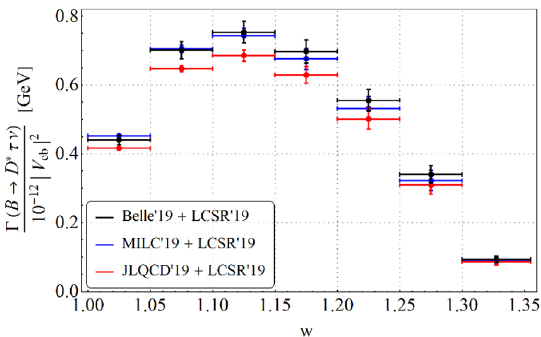
Figure 9. The di(cid:11)erential decay rate distributions (normalized by j V cb j 2 ) in w bins for B ! D (cid:3) (cid:28)(cid:23) (cid:28) decays in di(cid:11)erent (cid:12)t scenarios as explained in the text. The black bars are obtained using our (cid:12)t results with the Belle 2019 data and